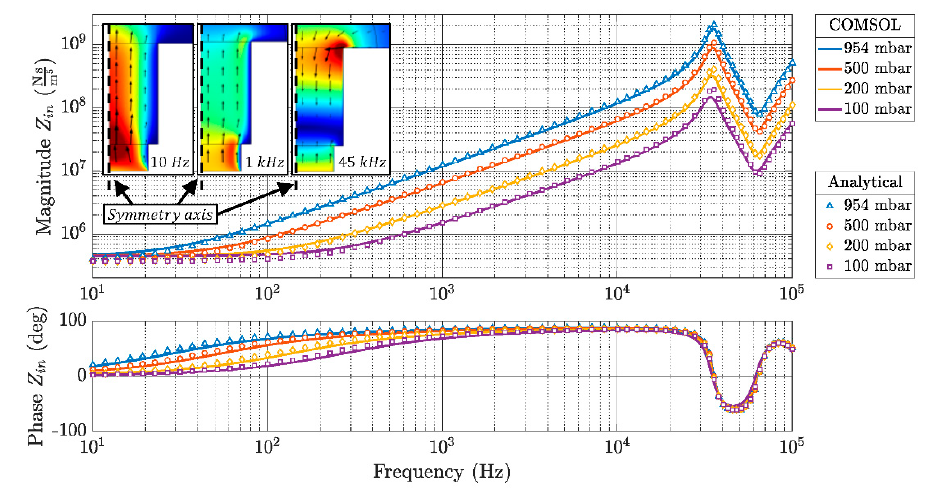
Figure 2. Comparison between the analytically computed acoustic input impedance 𝑍 𝑖𝑛 for different air pressure values and the results obtained by finite element simulations in COMSOL. The insets show exemplary velocity profiles inside the channel for different actuation